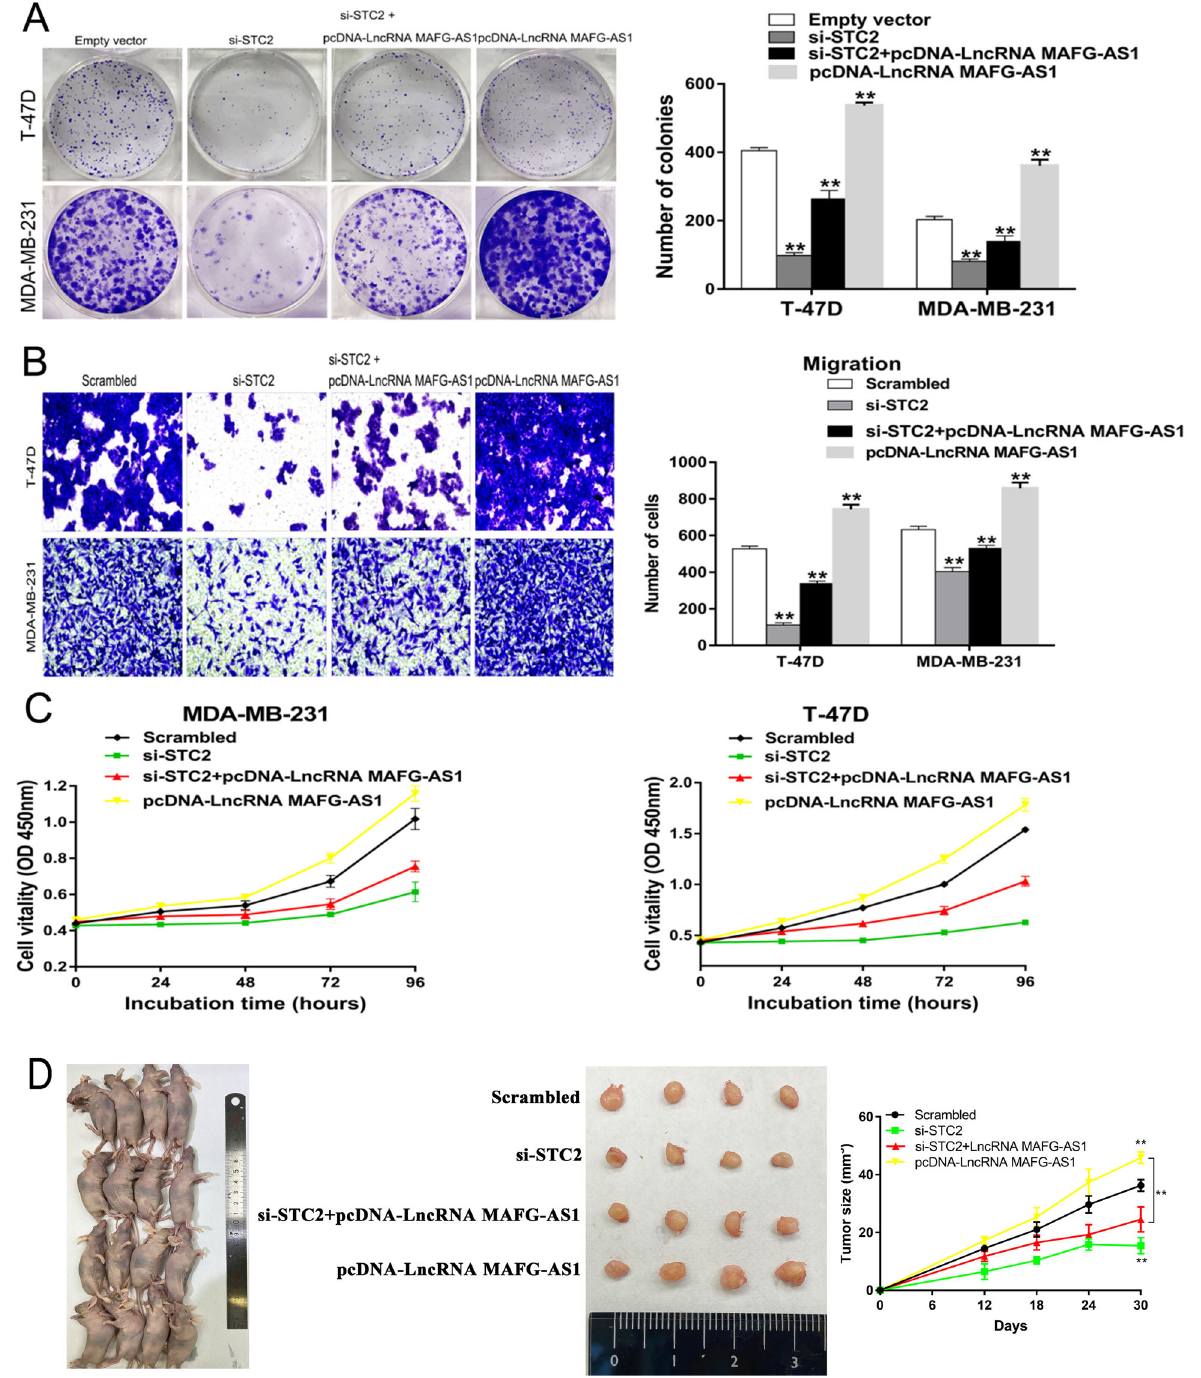
Fig. 8 Downregulation of STC2 inhibits BC cells proliferation and is involved in the oncogene function of LncRNA MAFG-AS1. A Colony formation assays were used to determine the proliferation for si-STC2 and pcDNA-LncRNA MAFG-AS1 co-transfected BC cells. B Transwell assays were used to evaluate the migration for si-STC2 and pcDNA-LncRNA MAFG-AS1 co-transfected BC cells. C CCK-8 assays were used to determine the cell viability for si-STC2 and pcDNA-LncRNA MAFG-AS1 co-transfected T-47D cells. D Nude mouse subcutaneous tumorigenesis assays were used to determine the cell-proliferation ability for si-STC2 and pcDNA-LncRNA MAFG-AS1 co-transfected in BC cells, the right was tumor volume curve. Values are shown as the mean ± s.d in three independent experiments. * P < 0.05, ** P < 0.01. squamous cell carcinoma [30], which indicated that STC2 took regeneration, stress response, and development [23, 24]. More- effect in cancer development and progression, including promot- over, it was discovered that the expression of STC2 changed ing cancer cells invasion and metastasis, suppressing the cells overtly in solid cancers such as colorectal cancer [25], nasophar- apoptosis and so on. Our fi ndings of the con fi rmatory test also yngeal carcinoma [26], endometrial carcinoma [27], gastric demonstrated that STC2 may take part in the regulatory network carcinoma [28], hepatocellular carcinoma [29], head and neck